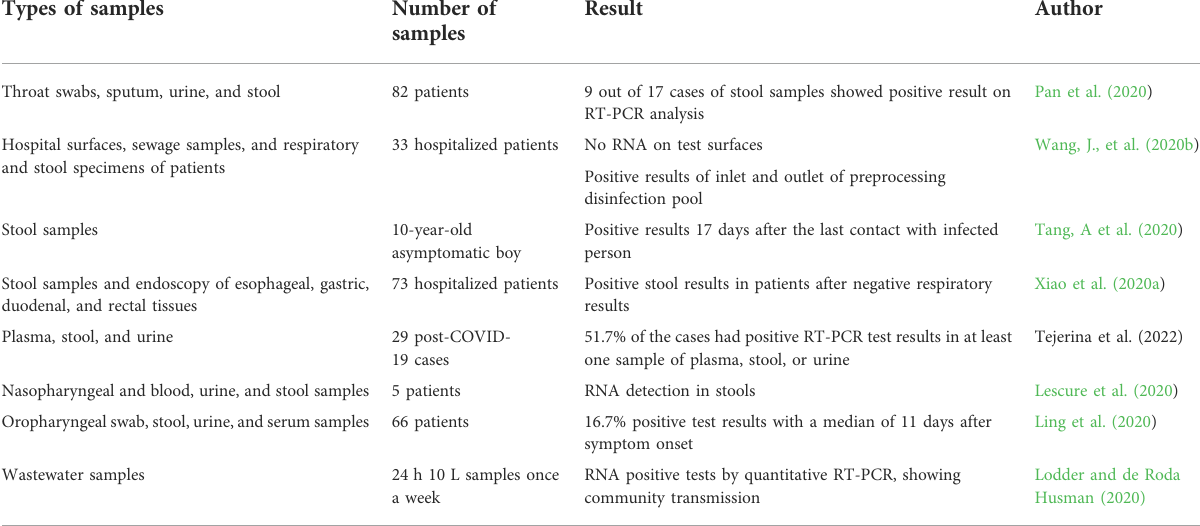
TABLE 6 Different conditions showing positive results for samples related to sewage and human